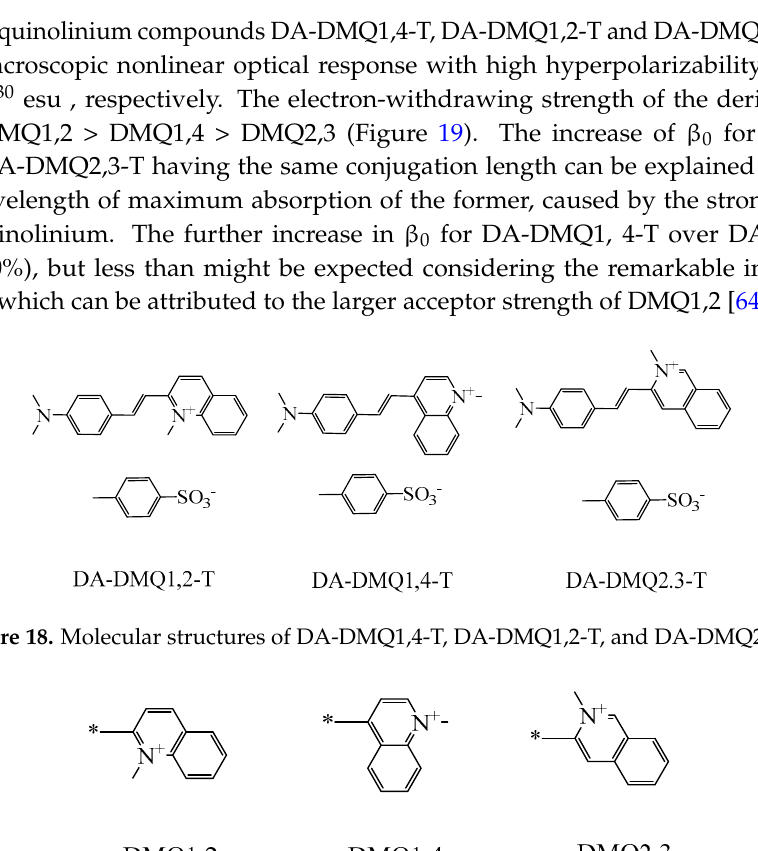
Figure 19. Molecular structures of DMQ1,2, DMQ1,4, and DMQ2,3.